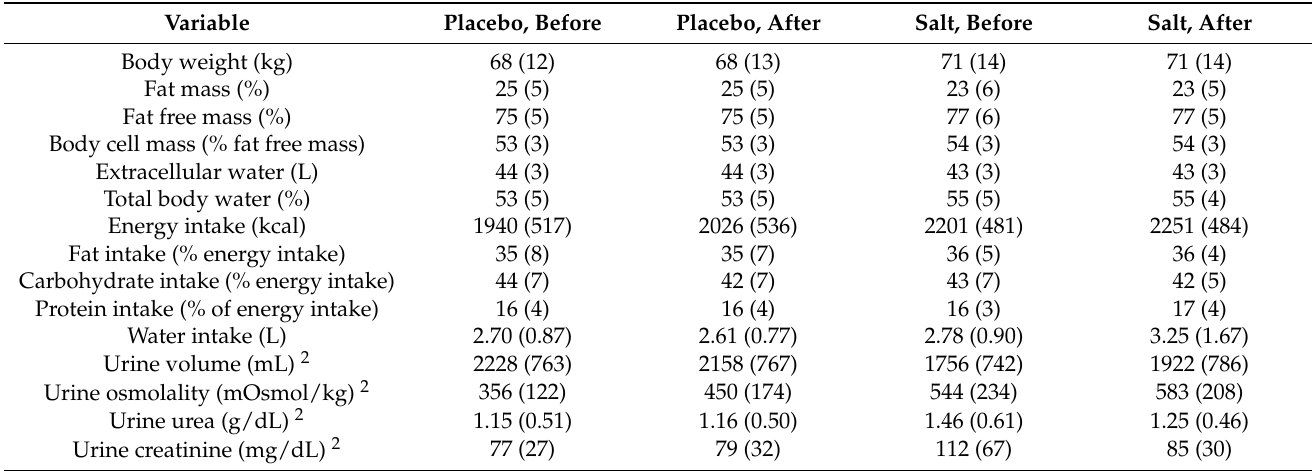
Table 2. Body composition, dietary intake, urine analysis, and cardiovascular parameters of healthy volunteers before and after 2 weeks of placebo or salt 1 .